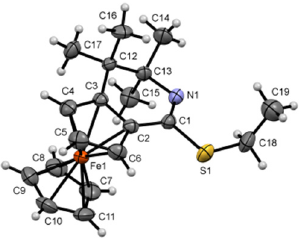
Figure 3. Molecular structure of 11a according to XRD data in the thermal ellipsoids of the 50% probability level (only the ( S p )-enantiomer is shown).